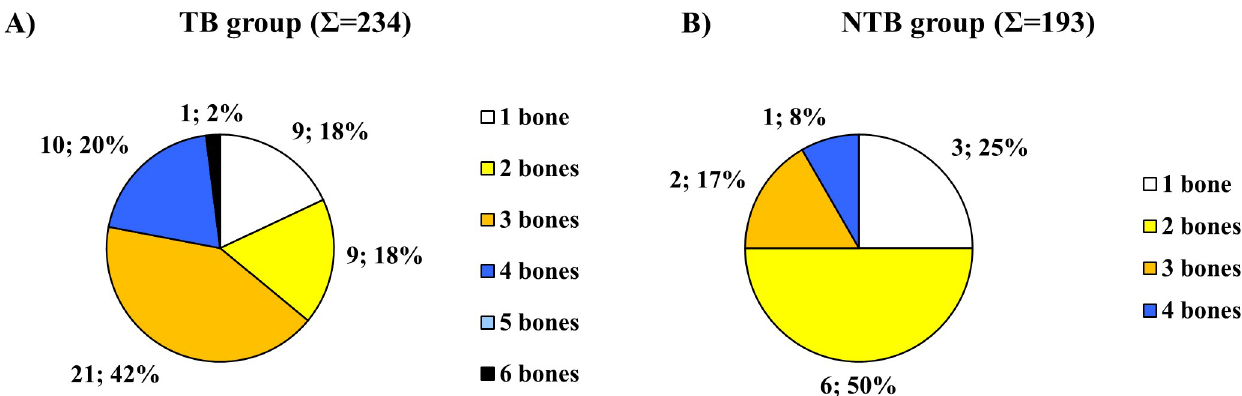
Fig 4. Distribution of individuals affected by ABVIs in the A) TB group ( S = 50) and B) NTB group ( S = 12) by number of simultaneously involved cranial bones (considering the left and right greater wings of the sphenoid bone as two separate bones).